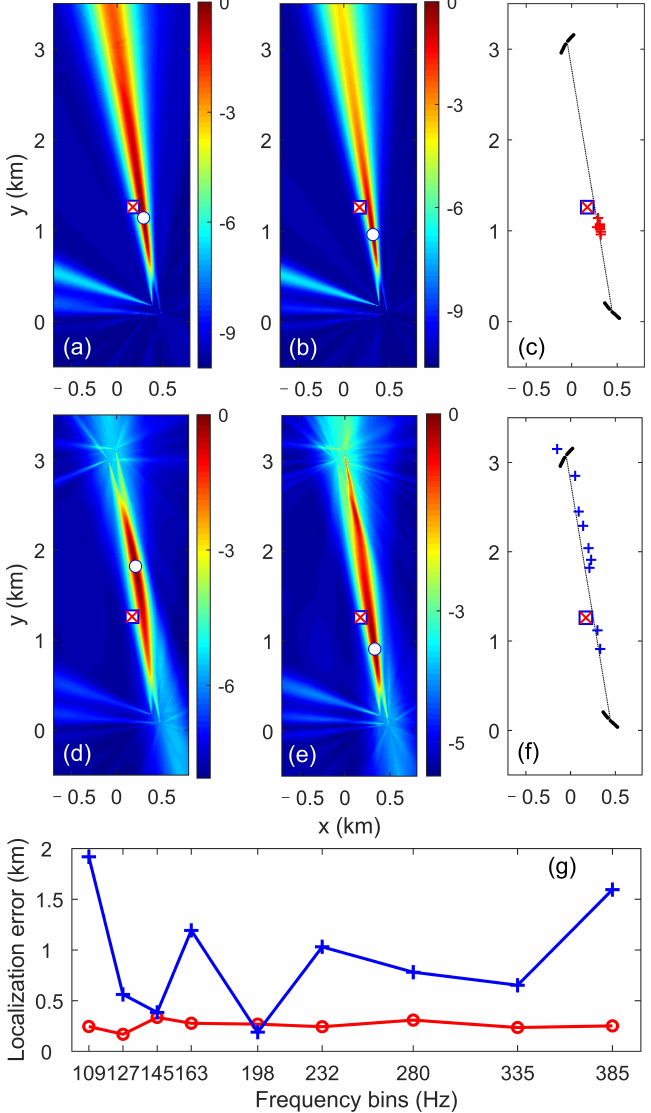
Figure 3. (Color online) Localization results of GMA and N-MUSIC with nine tone frequencies at segment 2. ( a , b ) Spatial spectra of GMA with 127 Hz and 145 Hz. ( d , e ) Spatial spectra of N-MUSIC with 127 Hz and 145 Hz. True source position is indicated by red cross symbol inside the square. Estimated source position is indicated by white circle. ( c , f ) Position estimates of GMA (red symbols) and N-MUSIC (blue symbols) with nine shallow tone frequencies. ( g ) Localization errors of GMA (solid red line with red circles) and N-MUSIC (solid blue line with plus